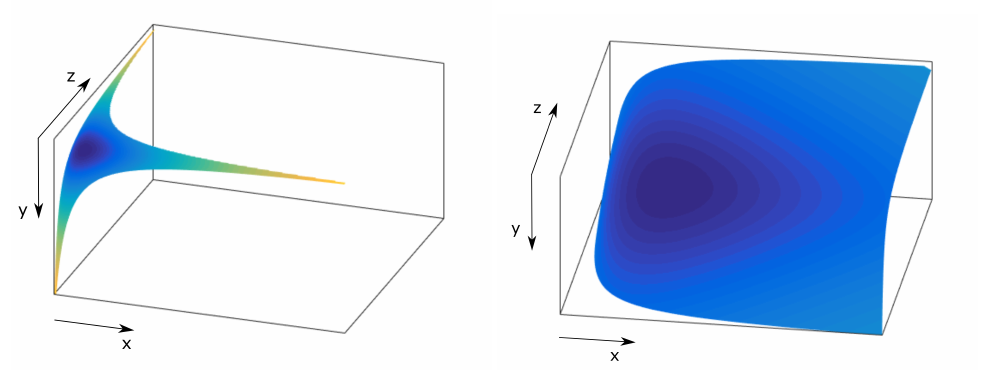
Figure 7. Example of hyperboloid layers for a 32 × 32 × 32 symbol 3D array. Left hand-side graph for K = 40 and right hand-side graph for K = 100.